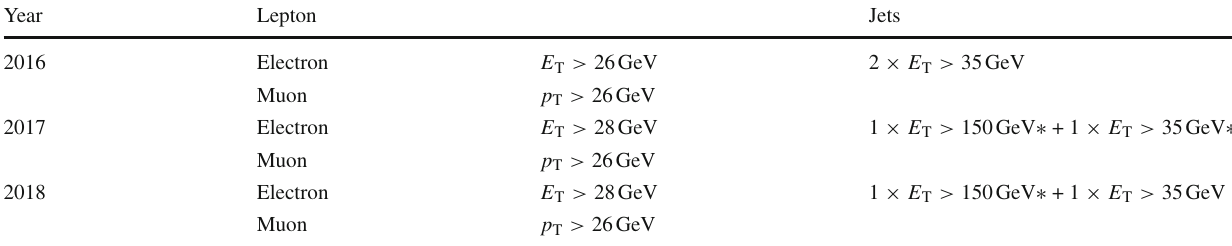
Table 9 Details of the triggers used to select a data sample to per- form the calibrations. Electrons (muons) are required to be isolated and pass a ‘Tight’ [62] (‘Medium’ [65]) identification working point. Jet E T thresholds denoted ∗ indicate that the GSC was applied and the value